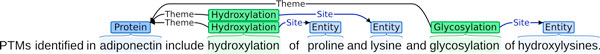
Example EPI event annotation. Three stated post-translational modifications of adiponectin are captured through three events, two of which differ only in their Site arguments. (Simplied from PMID 16497731).